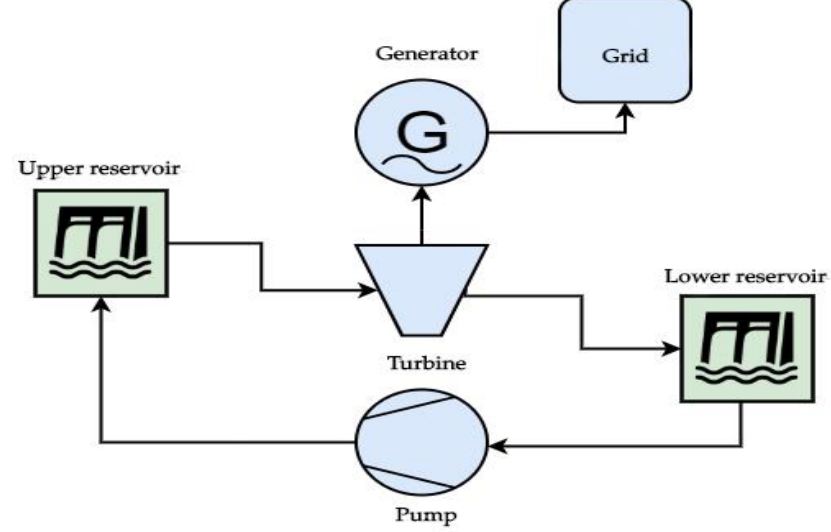
Figure 1. Structural block diagram of pumped hydroelectric energy storage.